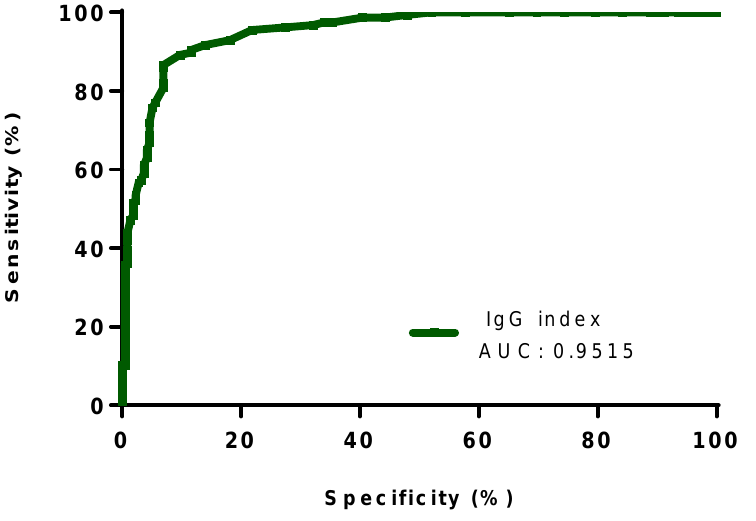
Figure 3. The ROC curve of the IgG index for the discrimination between OCB-positive (n = 157) and negative (n = 215) patients. Abbreviations: AUC, area under the curve.